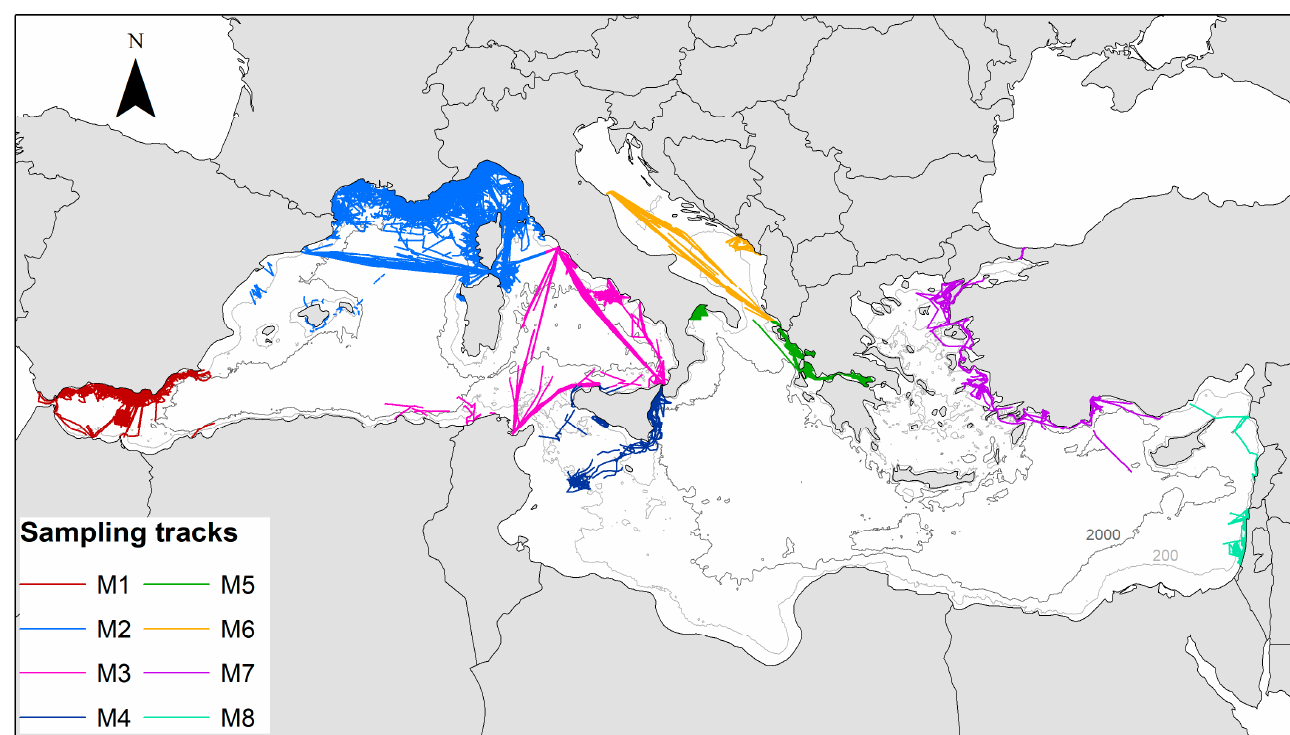
Figure 1. The sampling tracks performed by the research partners (2004–2018, 795,989 km in total). The isobaths represented (200 m, 2000 m) identify the three main bathymetric domains analysed: 0–200 m, 200–2000 m, >2000 m.